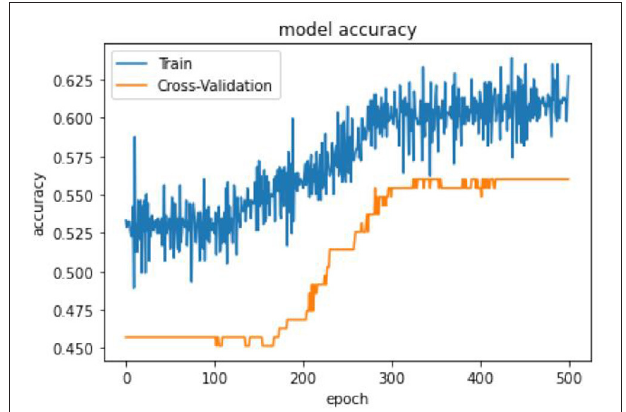
FIGURE 10 | ANN model accuracy-Main Land China.